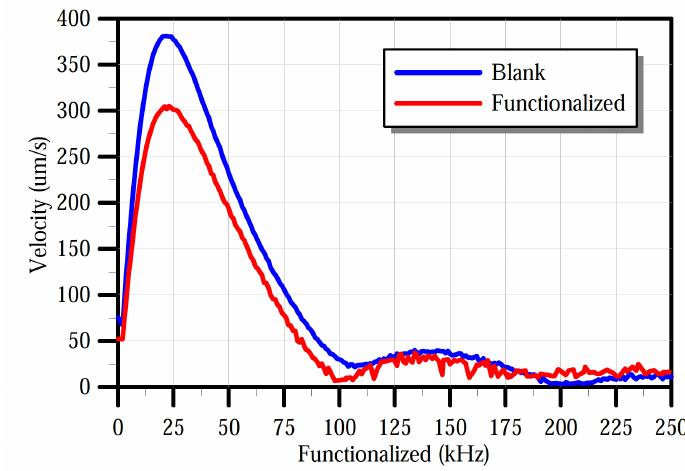
Figure 11. Frequency response of the sensor before and after functionalization with PANI. Table 1. Pull-in voltages (V) for the sensor with and without polymer under sawtooth loading.